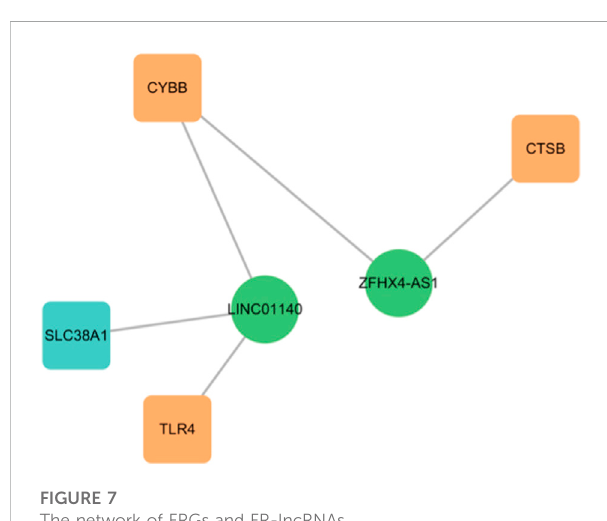
FIGURE 7 The network of FRGs and FR-lncRNAs.